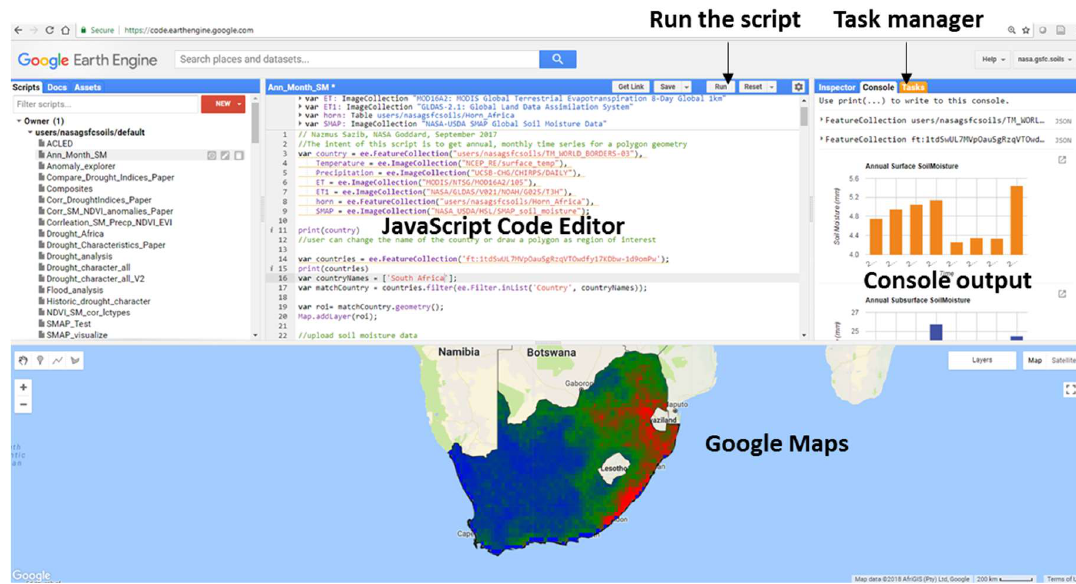
Figure 5 . Components of Google Earth Engine code editor. Figure 5. Components of Google Earth Engine code